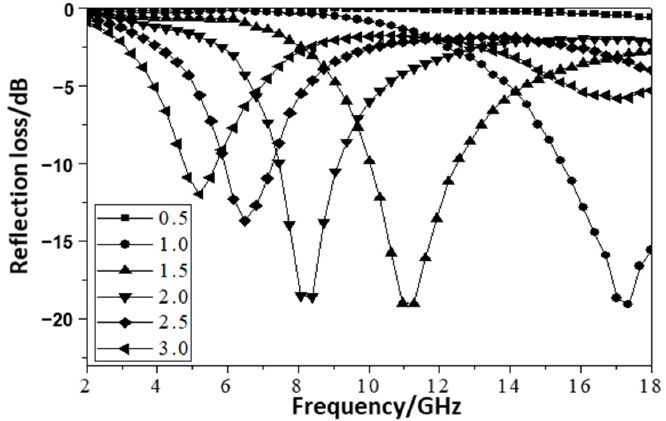
Figure 6. The color map of reflectivity values of ( a ) NiFe 2 O 4 and ( b ) NiFe 2 O 4 /MWCNTs composite.